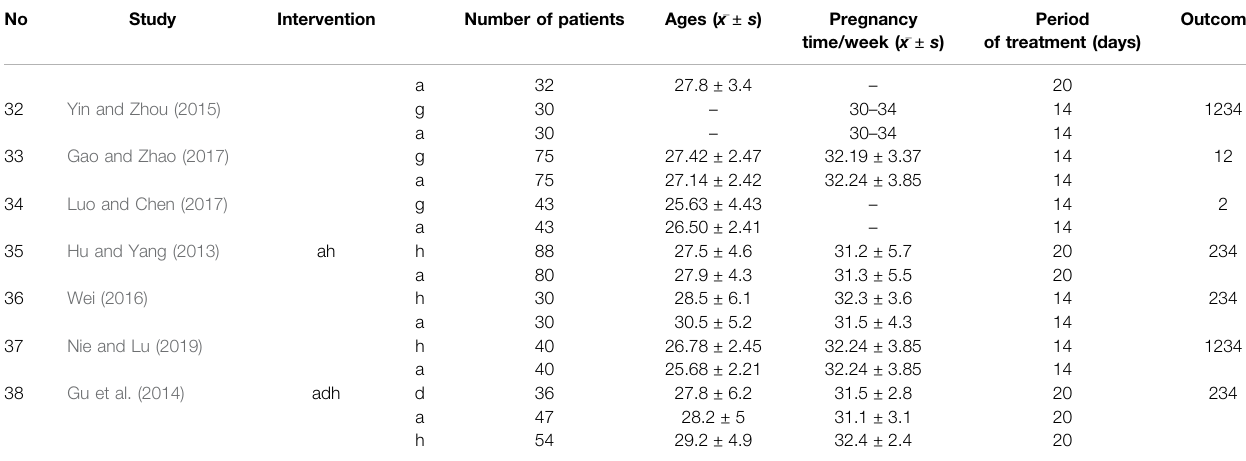
( Table 3 ). Primary outcomes included pruritus score and the level of ALT, AST, and TBA. Simultaneously, the missing or repeated data were excluded. Quality assessment